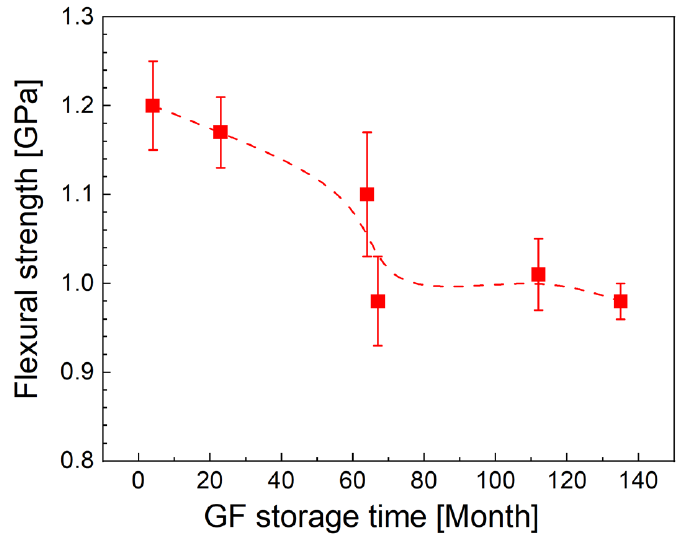
Figure 5. Flexural strength for GF/polyester composites reinforced with fibers with different storage times.